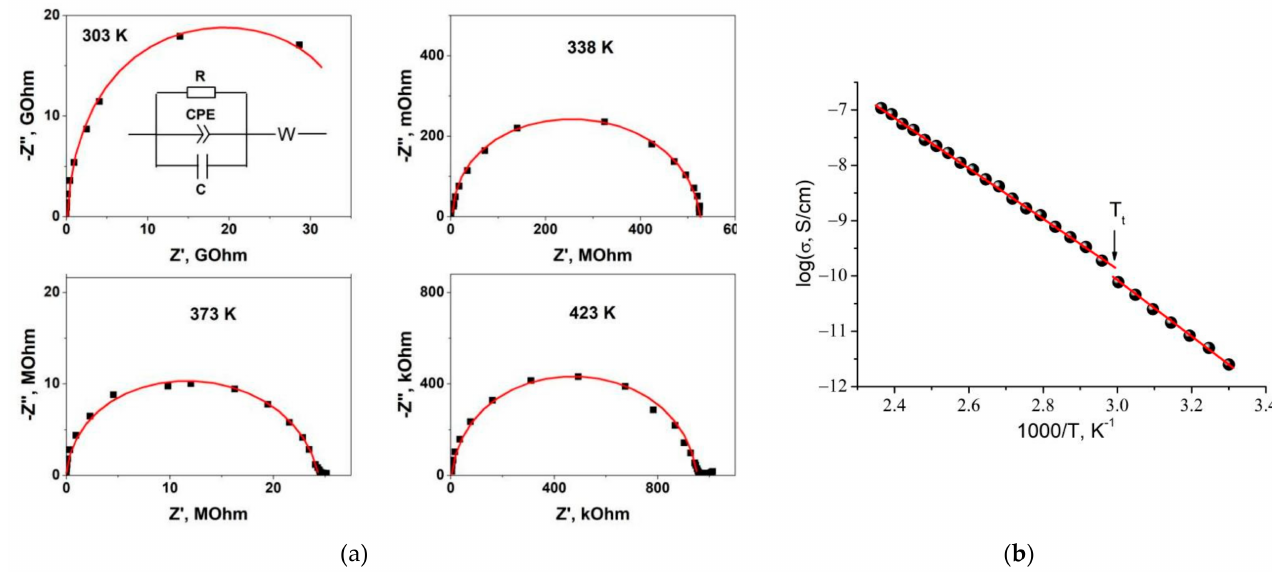
Figure 3. ( a ) Impedance plots obtained at different temperatures and the equivalent circuit used for the data fitting; points are experimental data and lines are fitting curves; ( b ) Arrhenius dependence of conductivity for TBAClO 4